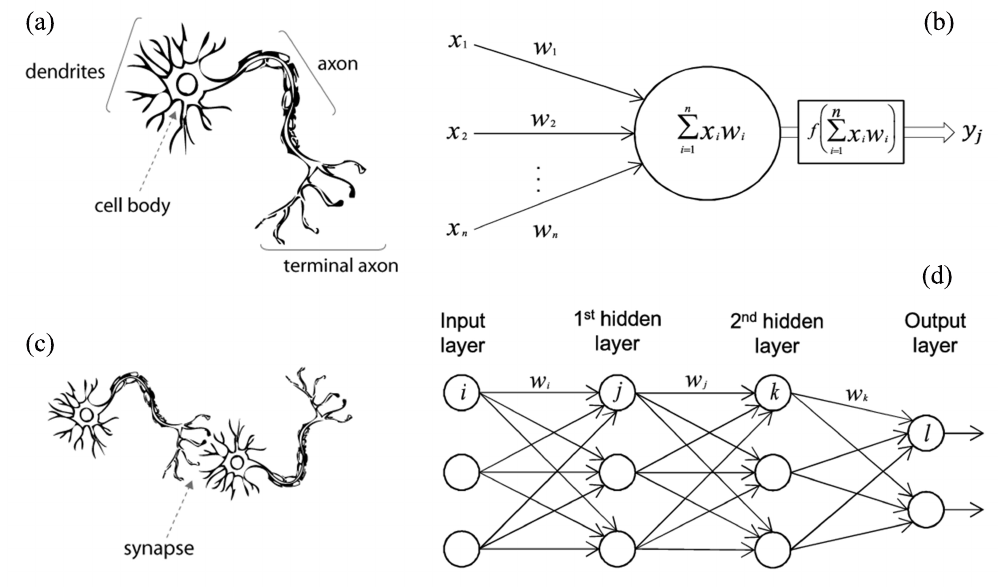
Figure 3. A biological neuron in comparison to an artificial neural network: ( a ) human neuron; ( b ) artificial neuron; ( c ) biological synapse; and ( d ) ANN synapses